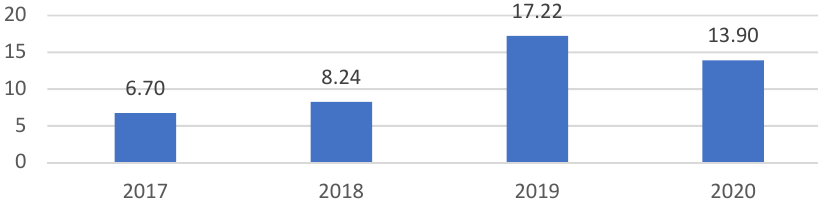
Figure 5. ROE (median) of biogas plants in 2017–2020 (%). Note: our calculations based on the biogas plant’s financial statements.